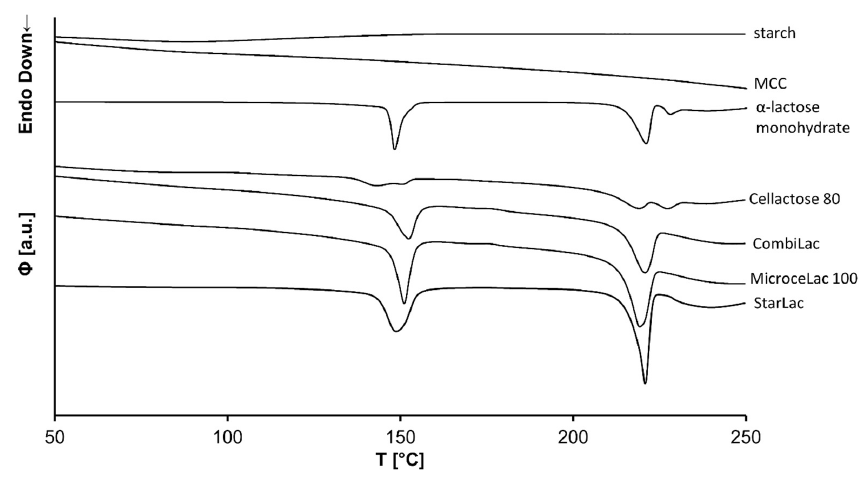
Figure 6. DSC analysis of components and CPEs.